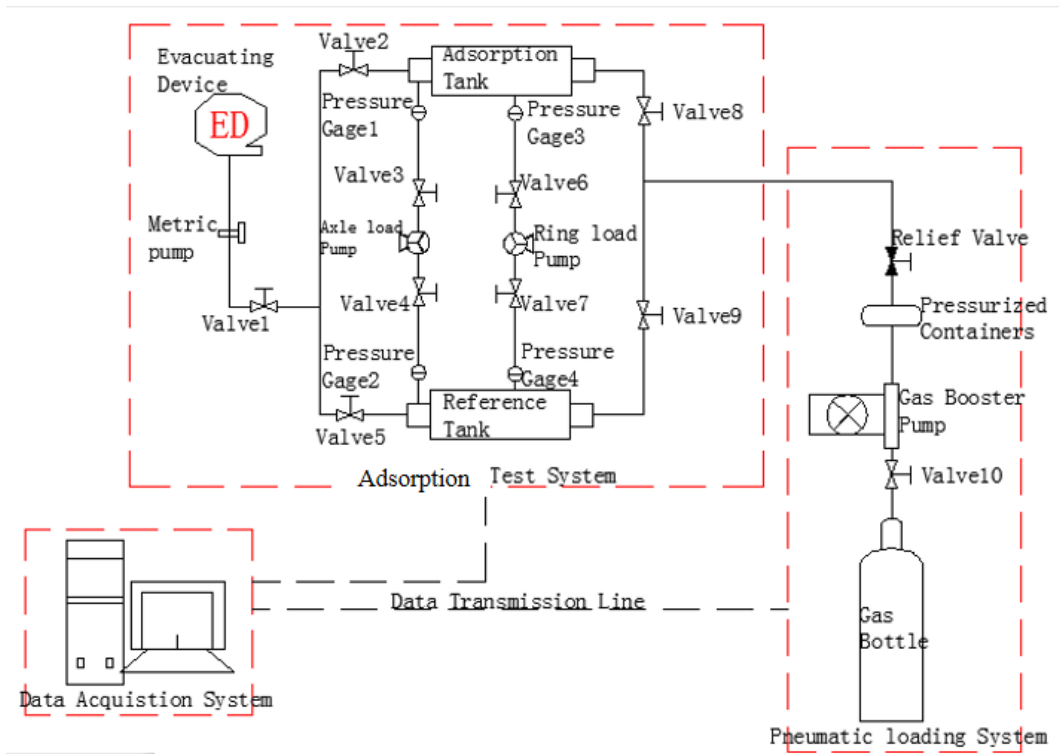
Figure 3 - Schematic diagram of the connection between the different parts of the